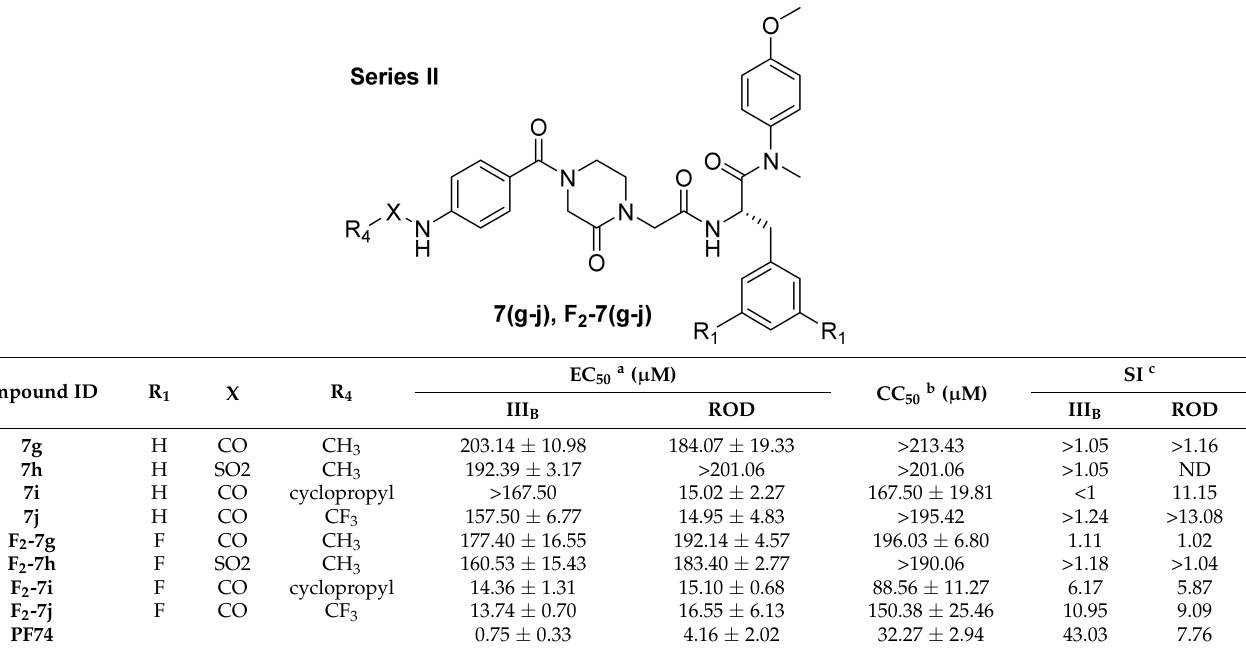
Table 2. Anti-HIV activity and cytotoxicity of series II in MT-4